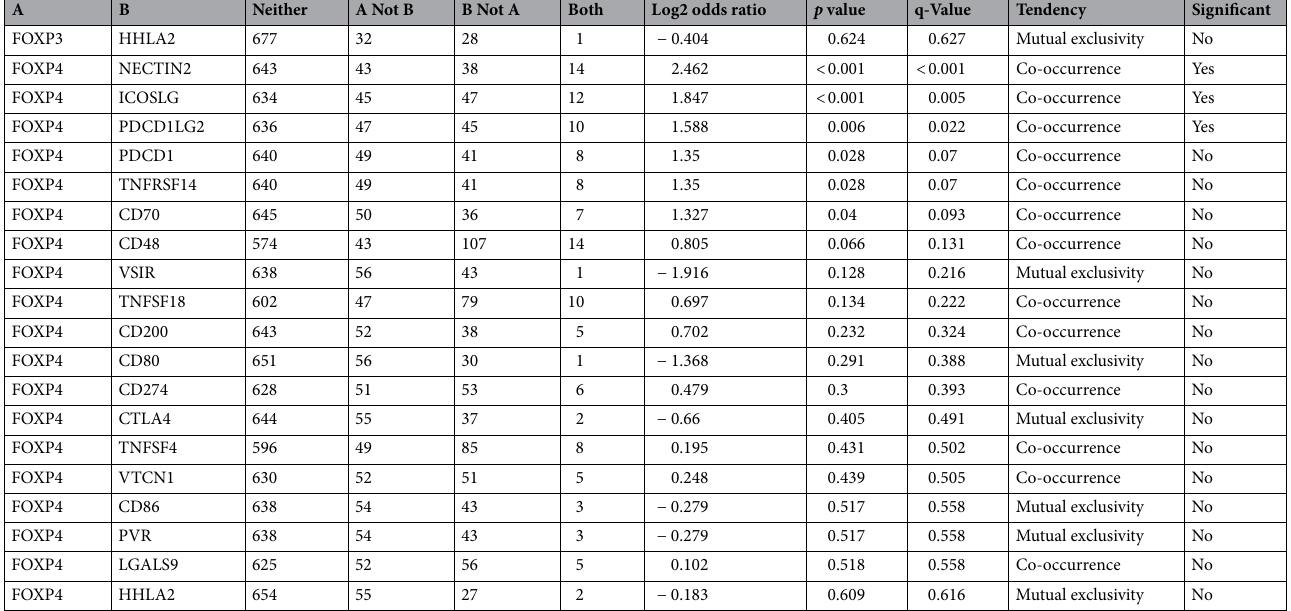
Table 2. Mutual-exclusivity analysis between FOXPs and multiple-immune checkpoints in